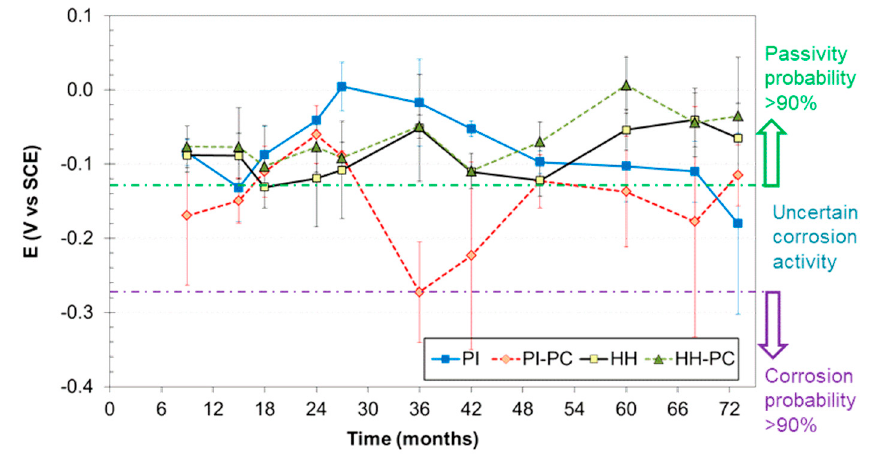
Figure 5. E corr values obtained for S32001 steel tested under different conditions.